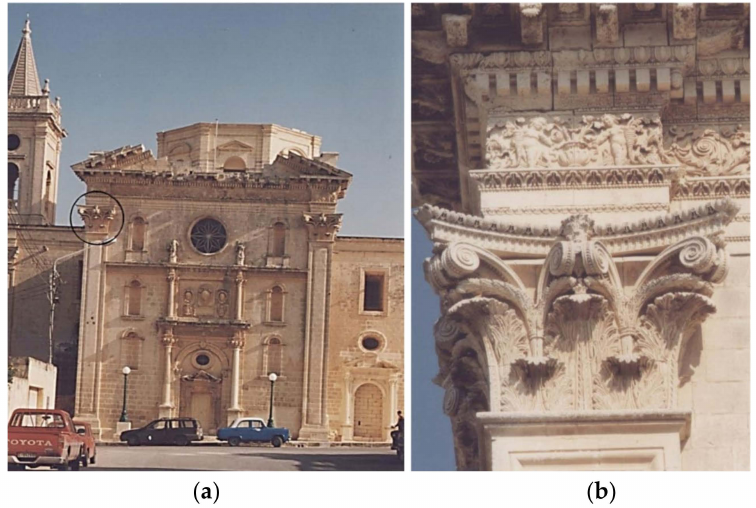
Figure 6. Dated photo of: ( a ) The Church of Santa Maria, Birkirkara; ( b ) Detail circled in black in ( a